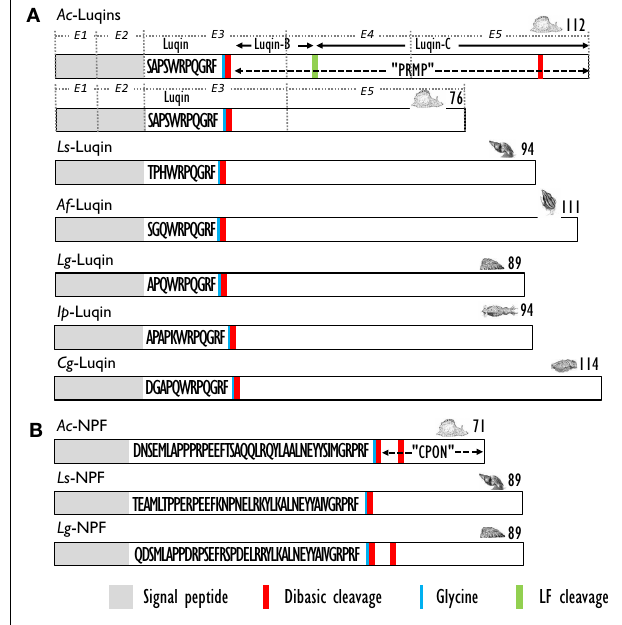
C-terminalproline-richmaturepeptide(PRMP)of 76aminoacids